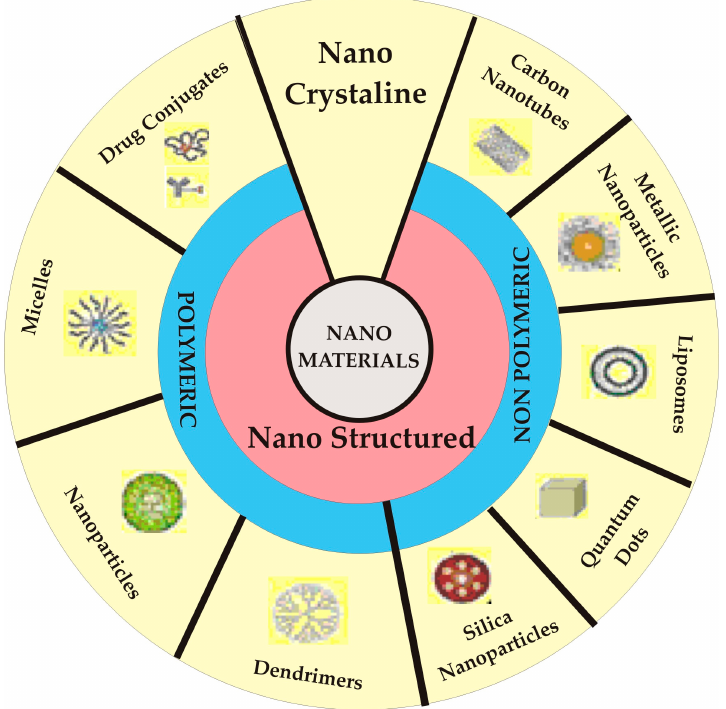
Figure 1. Illustrative representation of the different types of nanopharmaceuticals.